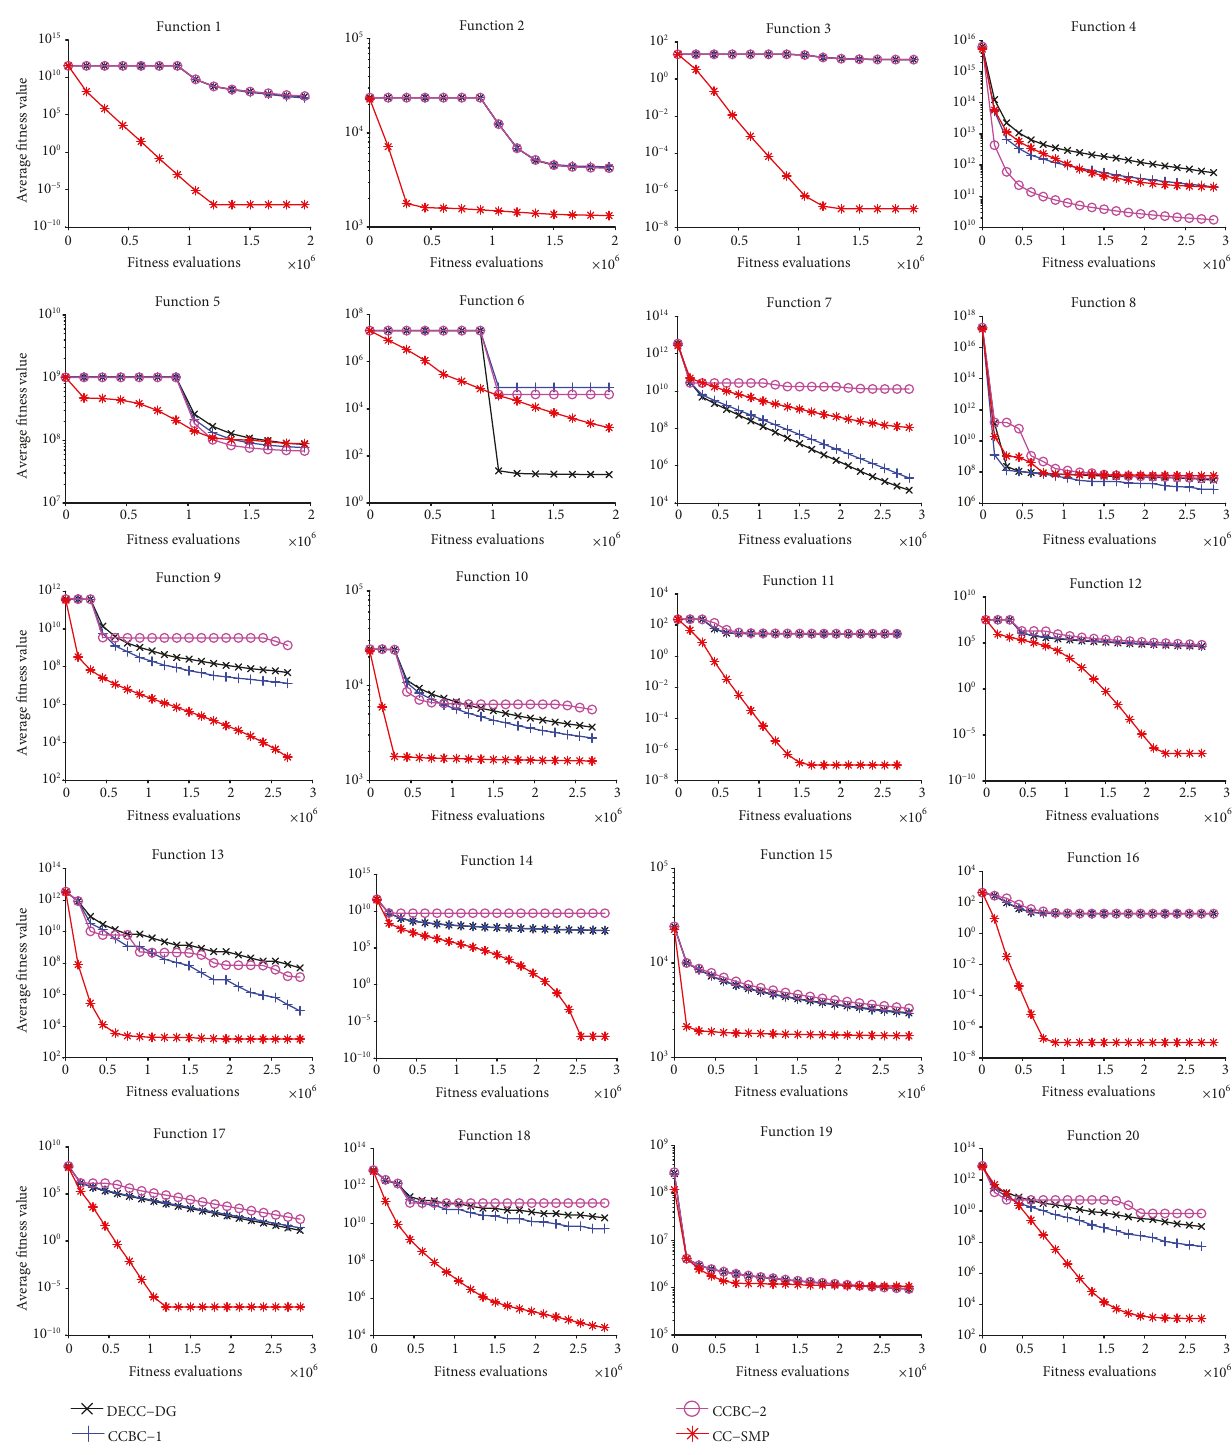
Figure 4: Convergence curves on CEC ’ 10 benchmark